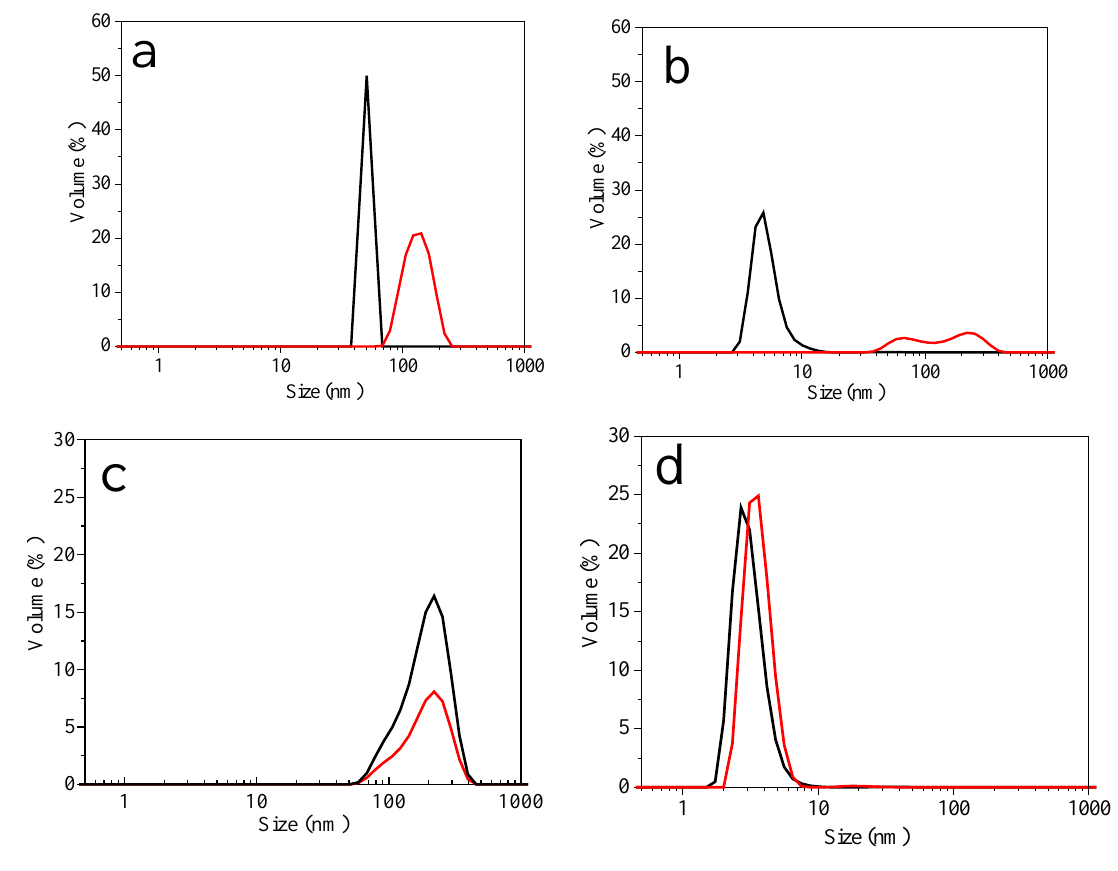
Figure 8. Size distribution profiles: ( a ) AgNPs P103 0.1%; ( b ) AgNPs P103 1%; ( c ) AuNPs P103 1%, and ( d ) AuNPs P103 10%. Before (black line) and after (red line) washing and centrifugation.